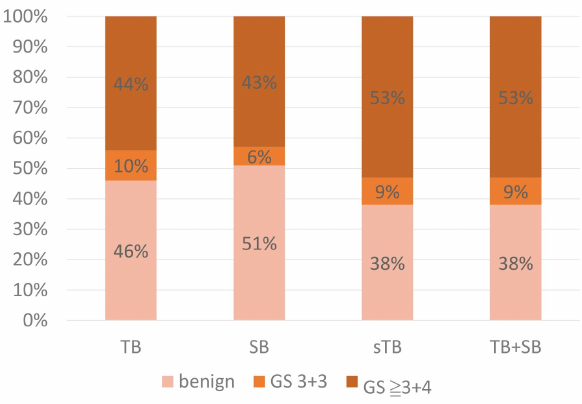
Fig. 3. The cancer detection rate of different biopsy templates.